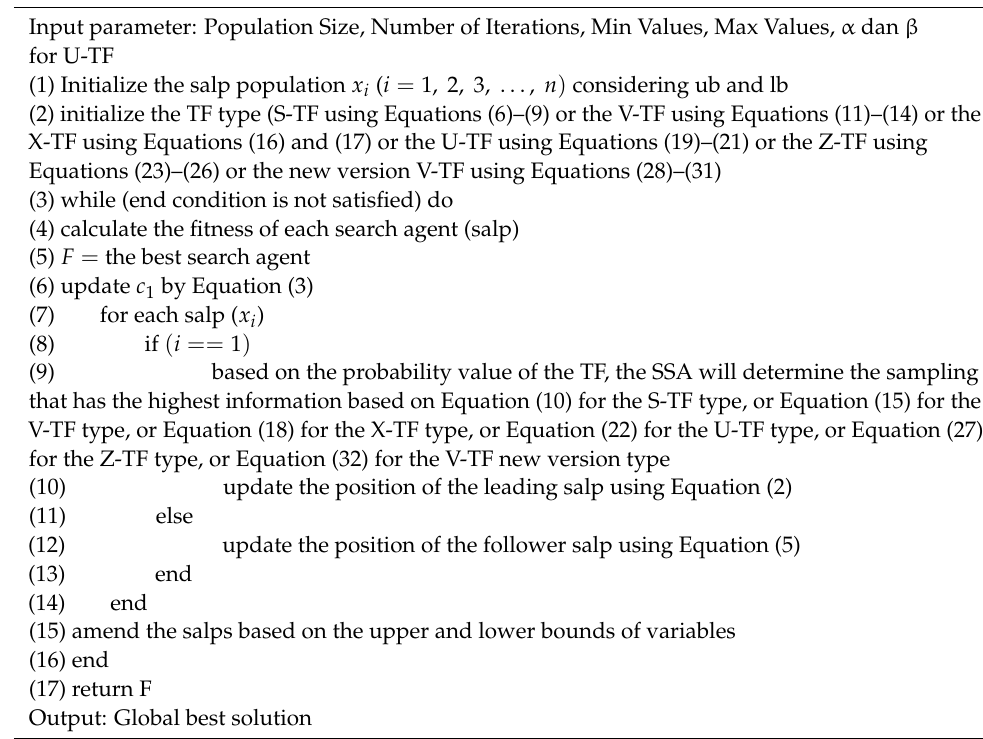
Algorithm 2. Salp Swarm Algorithm-Transfer Function